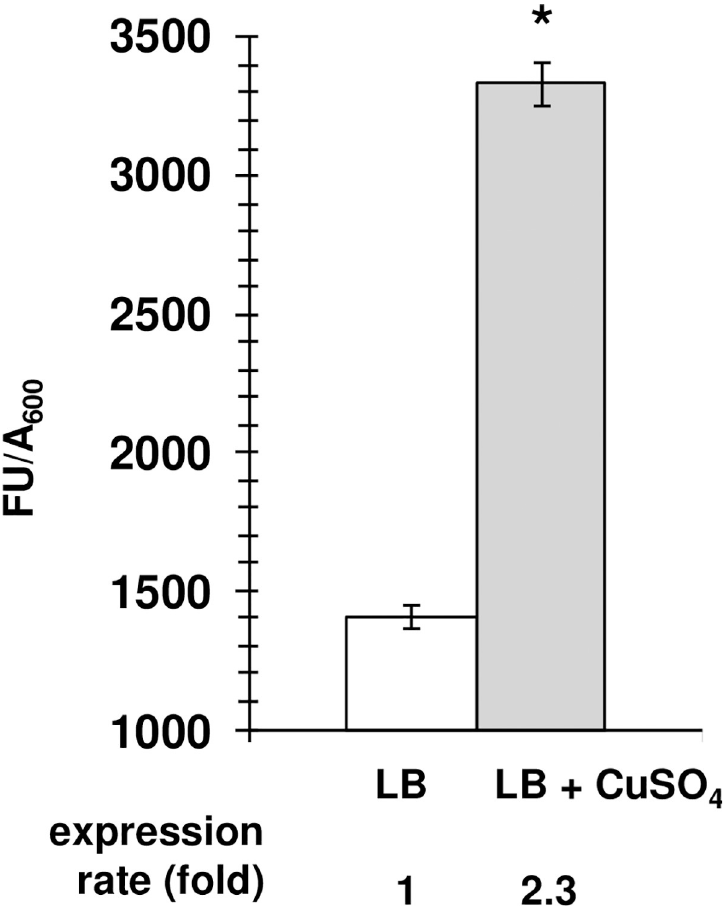
Fig 3. Copper significantly enhances the P [AAV] activity in vitro in Photorhabdus luminescens . Overnight mdtA -gfp cultures of P . luminescens carrying the P mdtA - gfp [AAV] fusion were diluted (1/500) in fresh LB medium in black-sided clear-bottomed 96-well plates (Greiner) and incubated at 28˚C, with shaking, in a microplate reader system (TECAN). 2mM Copper was added to the bacterial culture at mid log phase (O.D 600 equivalent to 0.4). Changes in A 600nm and GFP fluorescence were monitored after copper supplementation and the data shown are maximum specific fluorescence obtained by FU/A 600nm ratio value, calculated at six hours after the addition of copper. The results shown are the means of three experiments and asterisks indicate statistically significant differences ( � , P < 0.05) in paired Student’s t